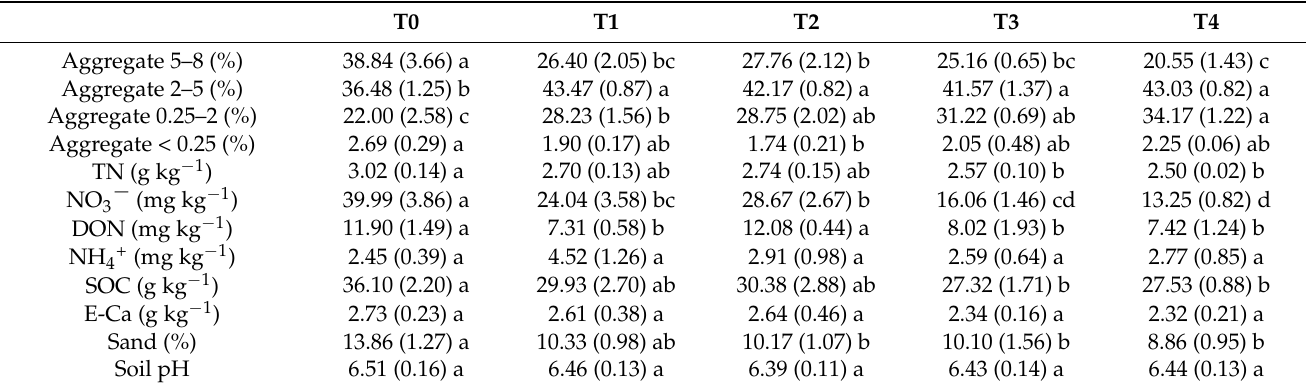
Table 2. Soil properties under different tillage frequencies after one-year simulation experiment. T0, no tillage; T1, semiannual tillage; T2, tillage every four months; T3, bimonthly tillage; T4, monthly tillage. Different letters indicate significant differences among treatments ( p < 0.05). Values in parentheses are standard errors ( n =